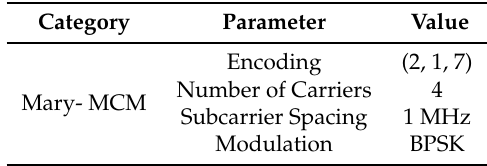
Table 1. Mary-MCM scheme simulation parameters.